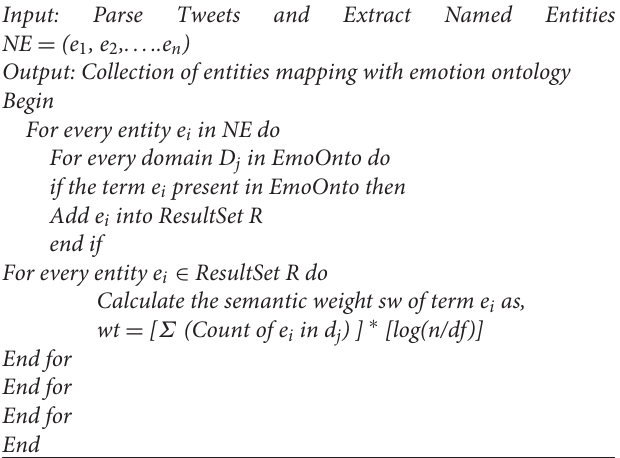
Algorithm: 1 Emotional Ontology-Based Entity Extraction and Weight